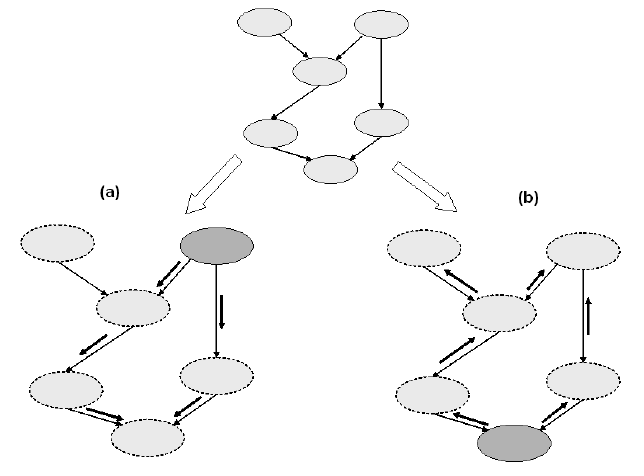
Figure 5: Illustration of two inference tasks in a